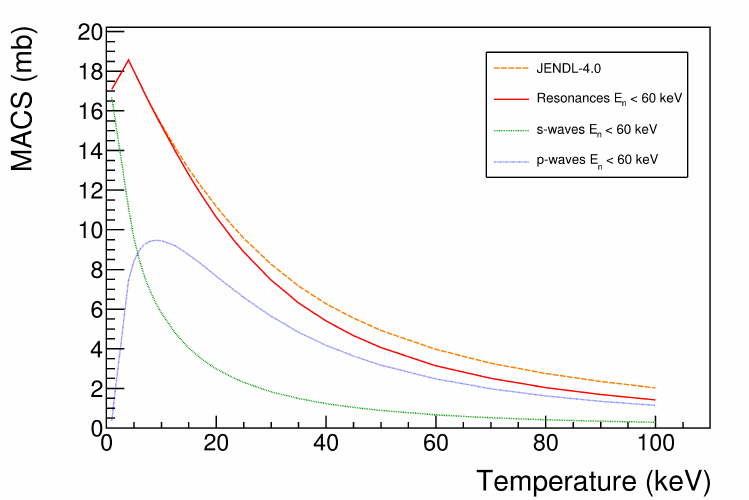
Figure 5. Maxwellian averaged cross-section calculated with the individual resonance parameters as provided by JENDL-4.0 (orange dashed line), compared with the contribution given by different sub-sets of